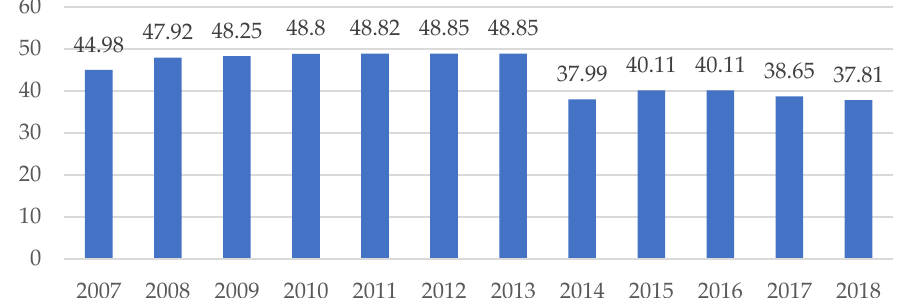
Figure 4. Forest cover change in Dak Lak province, 2007–2018 (%). Sources: Reproduced with permission from Dak Lak Forest Protection Department [67].